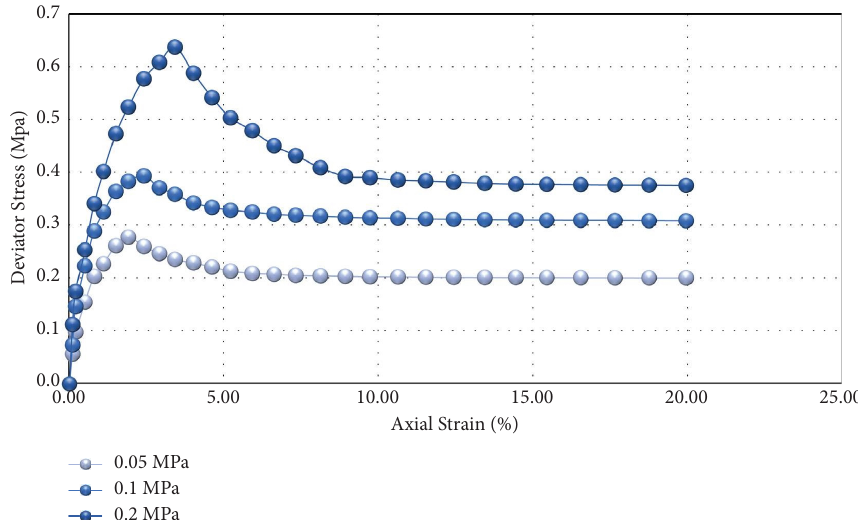
Figure 6: Deviator stress-strain curves for sample CR8 (8% CRHA treated soil 1 :2) after 28 days.